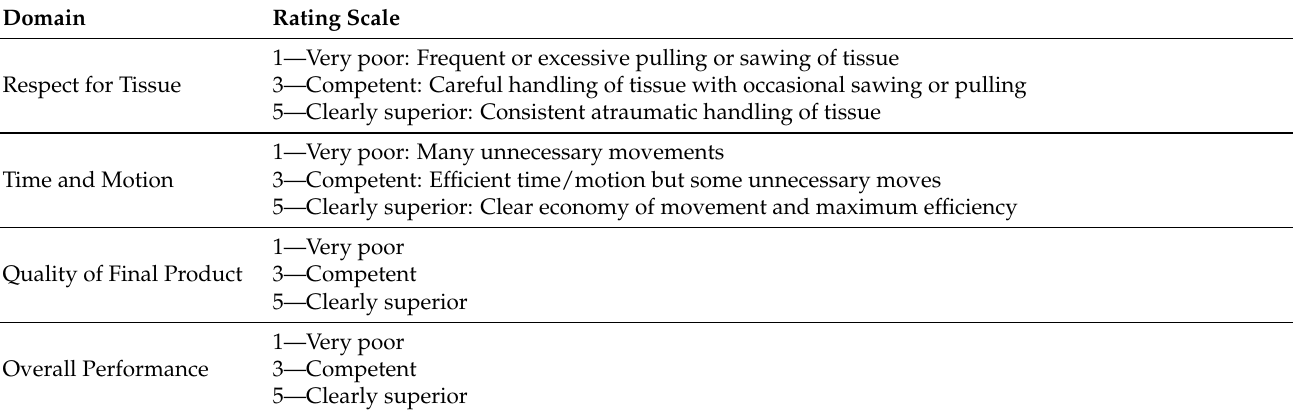
Figure 2. Participants came from 10 surgical divisions, with experiences ranging from PGY1 to Fellow. Table 1. Rating scale used when evaluating surgical skill on the GRS